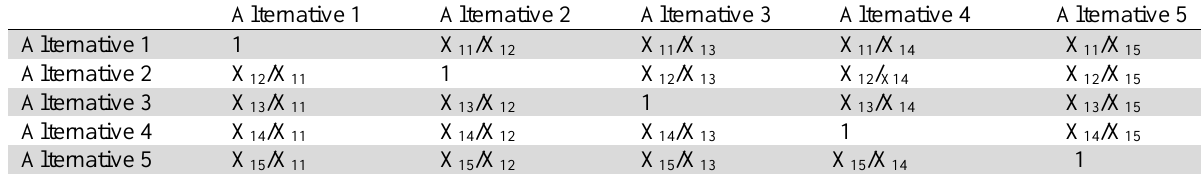
Pair wise Comparison matrix for capacity waste alternatives for parameter 1 (from Table 2)